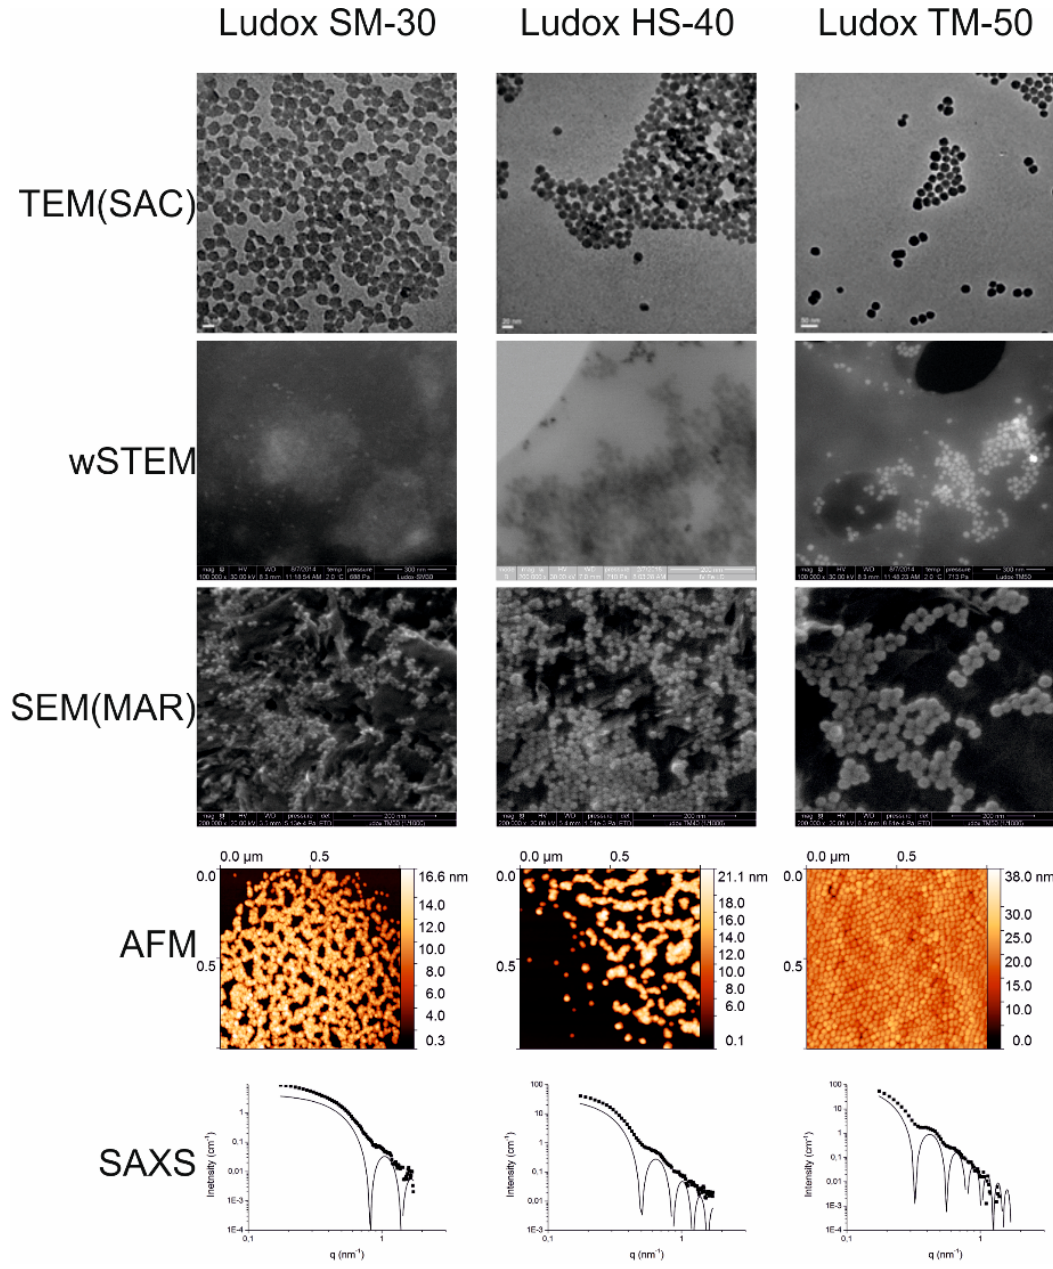
Figure 3. Typical experimental measurements of monodisperse silicate solutions (Ludox). According to the manufacturer’s documentation, the estimated size of SM-30 is 7 nm, HS-40 is 12 nm, and TM-50 is 22 nm. Experimental data include Transmission Electron Microscopy (TEM), wet Scanning Transmission Electron Microscopy (wSTEM), Scanning Electron Microscopy (SEM), Atomic Force Microscopy (AFM), and Small-Angle X-ray Scattering (SAXS). Scale bars are given on the EM images or on the x-axis and y-axis of AFM images. Height color scales are shown on the right of AFM